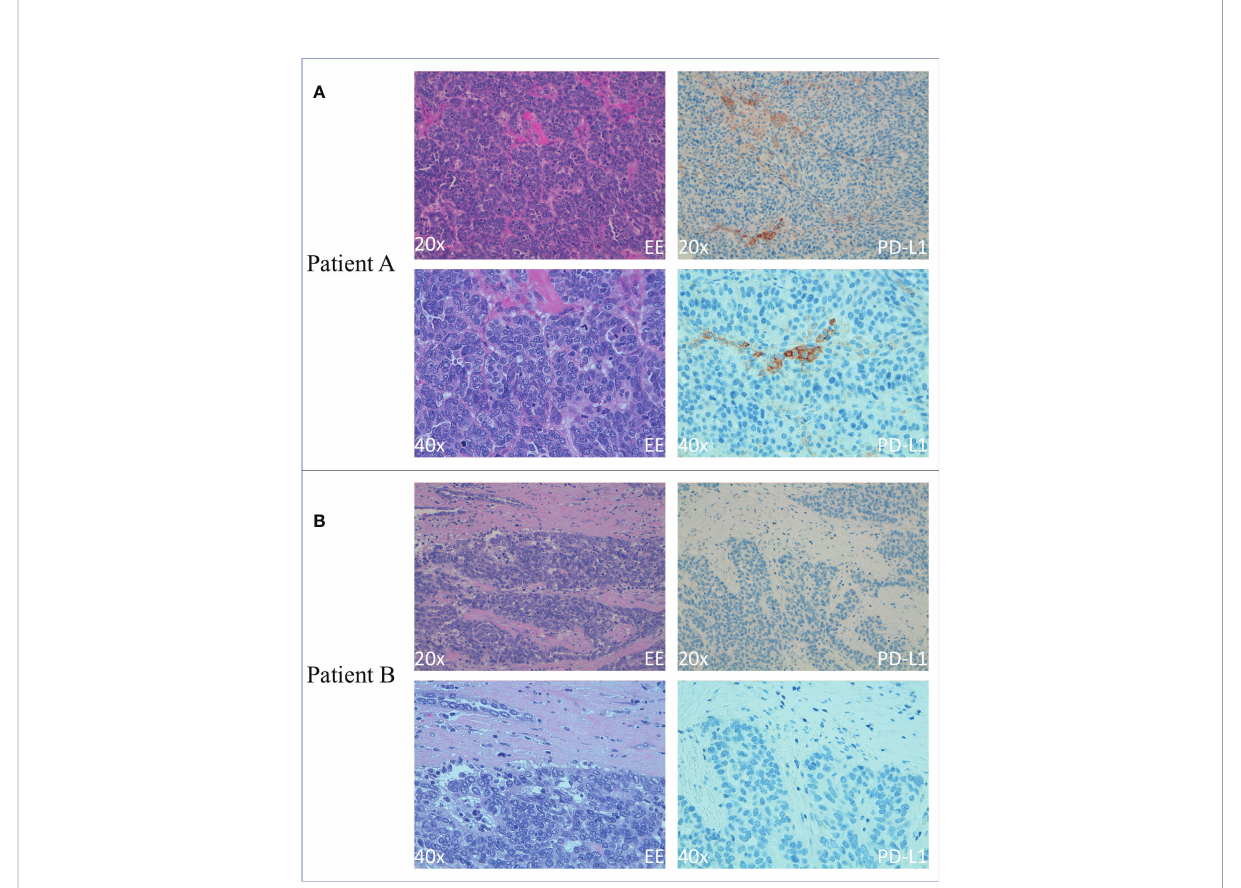
FIGURE 2 Immunohistochemical analysis of PD-L1 expression on OC cells from Patients A and B (A) Smaller (20×) (upper panels) and larger (40×) (lower panels) magni fi cation of primary OC showing hematoxylin-eosin staining (left panels) and PD-L1+ tumoral cells (right panels) of Patient A (B) Smaller (20×) (upper panels) and larger (40×) (lower panels) magni fi cation of primary OC showing hematoxylin-eosin staining (left panels) and PD-L1+ tumoral cells (right panels) of Patient B Scale bars in A and B are 100 m